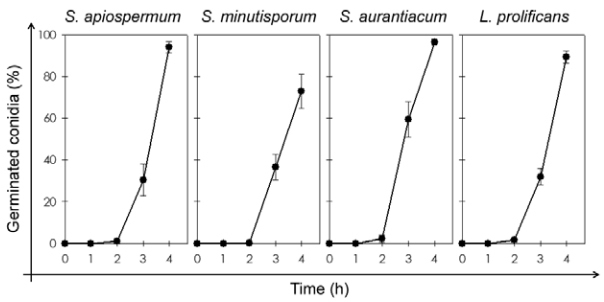
: time-dependence kinetics of conidial germination in Scedosporium apiospermum, S. minutisporum, S. aurantiacum and Lomentospora prolificans. Conidial cells were incubated in Sabouraud medium at 37ºC in an atmosphere of 5% CO2. After 0, 1, 2, 3 and 4 h of incubation, the number of non-germinated and germinated conidial cells (please, see representative images in Fig. 1) were counted by using an inverted microscope. The results are expressed as percentage of germinated conidia in comparison to remaining conidial cells. The results are shown as the mean ± standard deviation of three independent experiments.